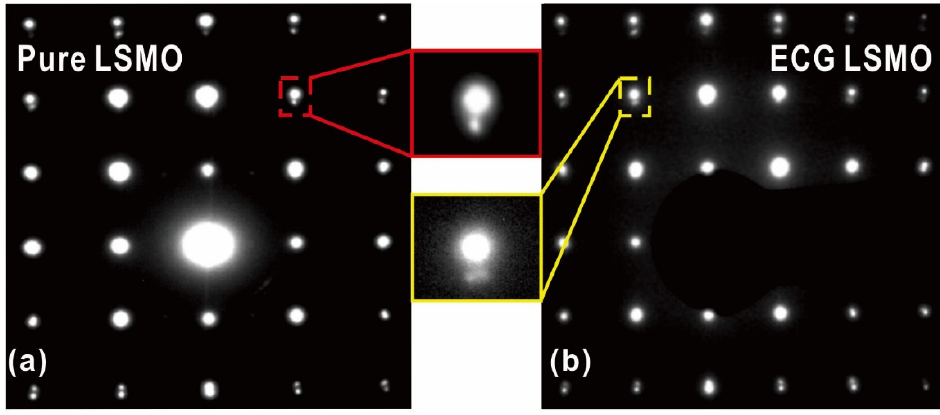
Figure 7. SAED patterns ( a ) pure LSMO; and ( b ) ECG LSMO covering both substrate and film along [001] LAO direction.